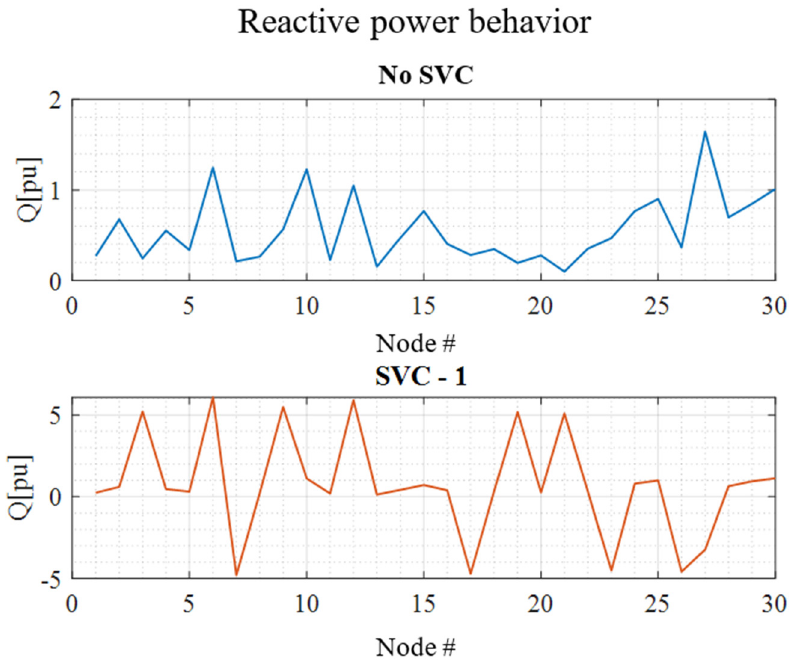
Figure 18. Profile of nodal reactive power in the IEEE 30-bus test system.